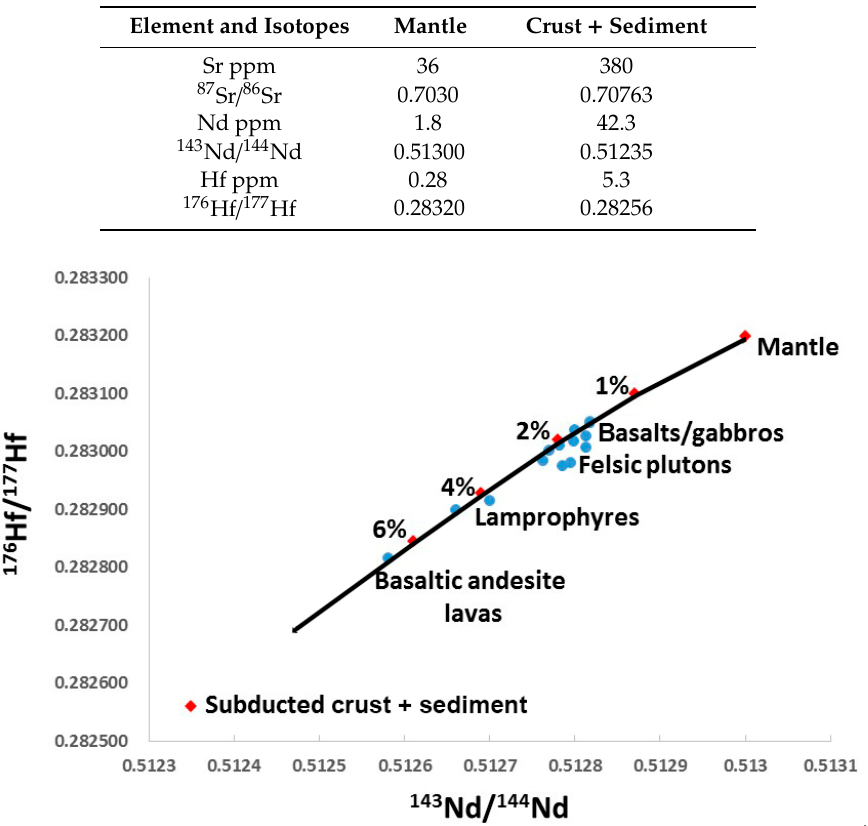
Figure 9. 176 Hf / 177 Hf versus 143 Nd / 144 Nd for samples from El Teniente (Table 4; blue circles) compared to isotopic values of a primitive mantle (Table 5) modified by the addition of various proportions (red diamonds) of subducted crust and sediment.